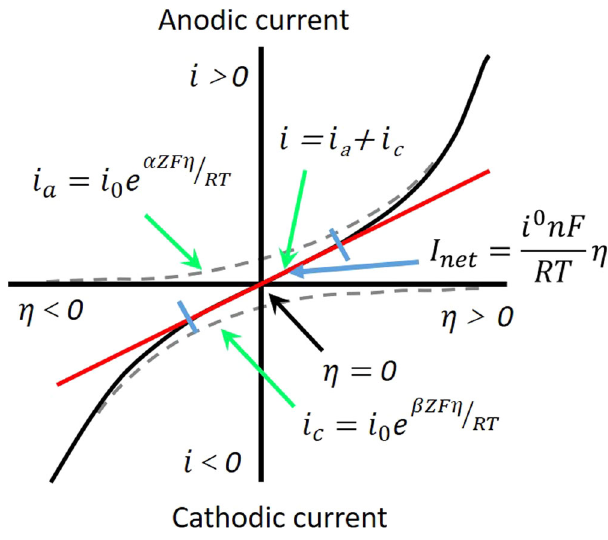
Fig. 1 Electrochemical polarization curve. The electrochemical polarization curve shows how the battery voltage shifting away from its OCV, which can be considered as its thermodynamic equilibrium voltage. The difference of a battery voltage during charge or discharge with its OCV is overpotential. i a and i c are the anodic and cathodic current density, respectively; α and β ( = 1 − α ) are the charge transfer coef fi cient of anode and cathode, respectively; η is charge transfer overpotential; R is gas constant and F is Faraday